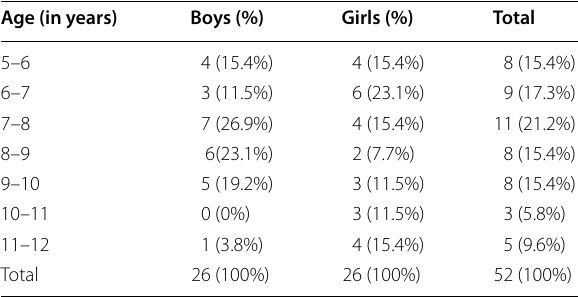
Table 3 Age and sex distribution on